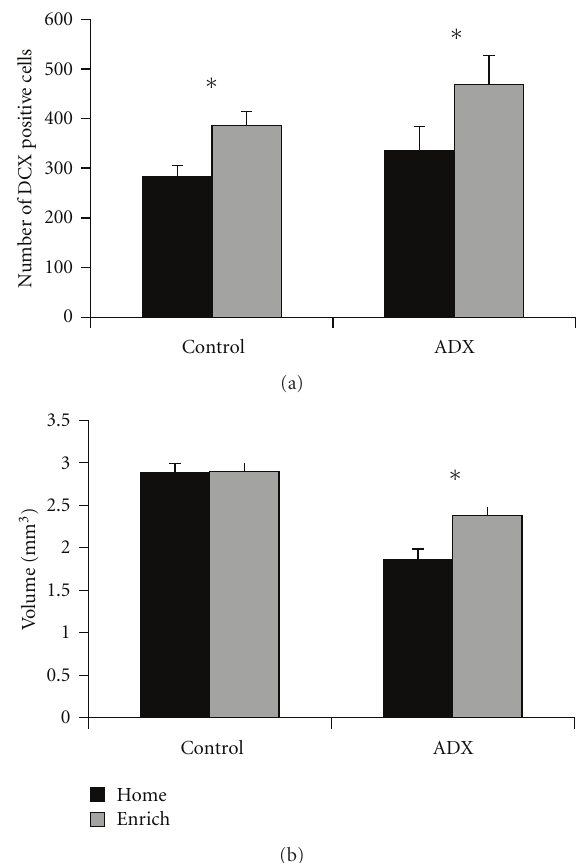
Figure 6: (a) Our alternating treatment of enrichment and wheel running significantly increased the number of doublecortin (DCX) positive cells in the dentate gyrus of adrenalectomy (ADX) and con- trol rats. (b) Chronic ADX significantly reduced the volume of the dentate gyrus granule cell layer. Most importantly, a combination of six weeks of enriched housing significantly increased the volume of the dentate gyrus granule cell layer in ADX rats, compared to their home cage counterparts. Error bars represent standard error of the